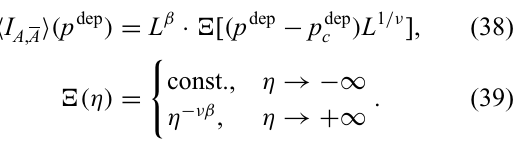
(cid:7) ( L = A A , A (cid:7) according A , A